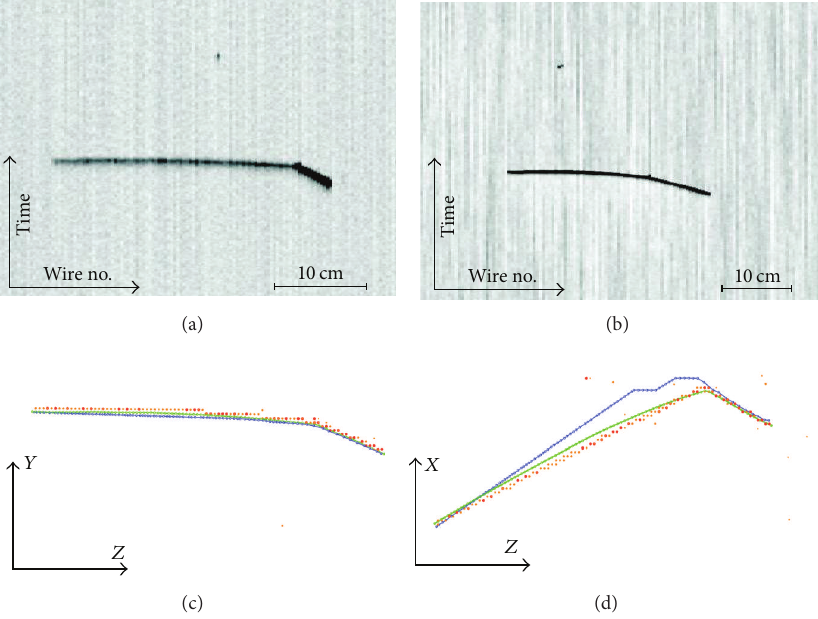
Figure 8: Simulation and reconstruction of a proton track: (a) Collection wire view; (b) Induction2 wire view; (c) and (d), respectively, YZ and XZ views of the MC cells (orange dots) and the track reconstructed: using matching 2D projections by drift timing (blue curve) and using 3D fit optimized to 2D projections (green curve).